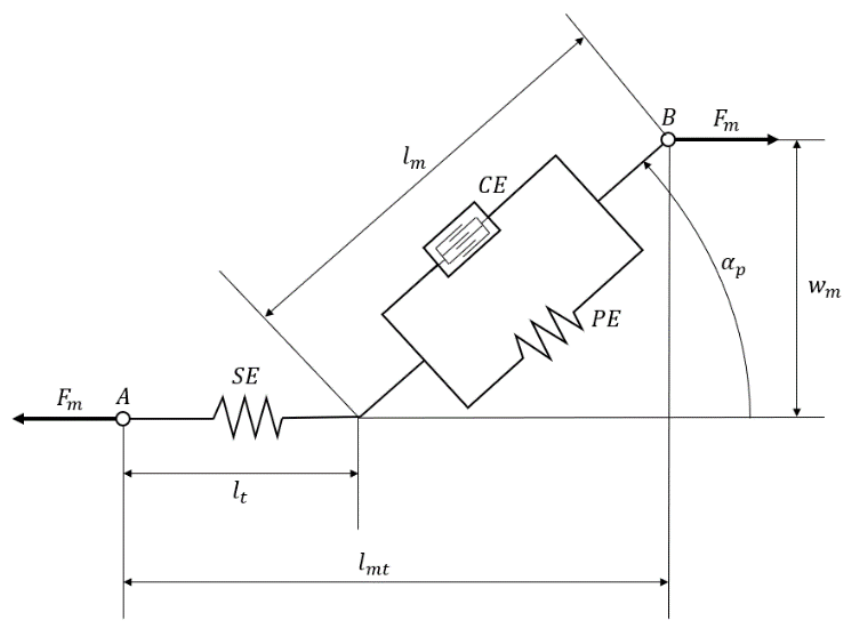
Figure 3. Hill muscle scheme.